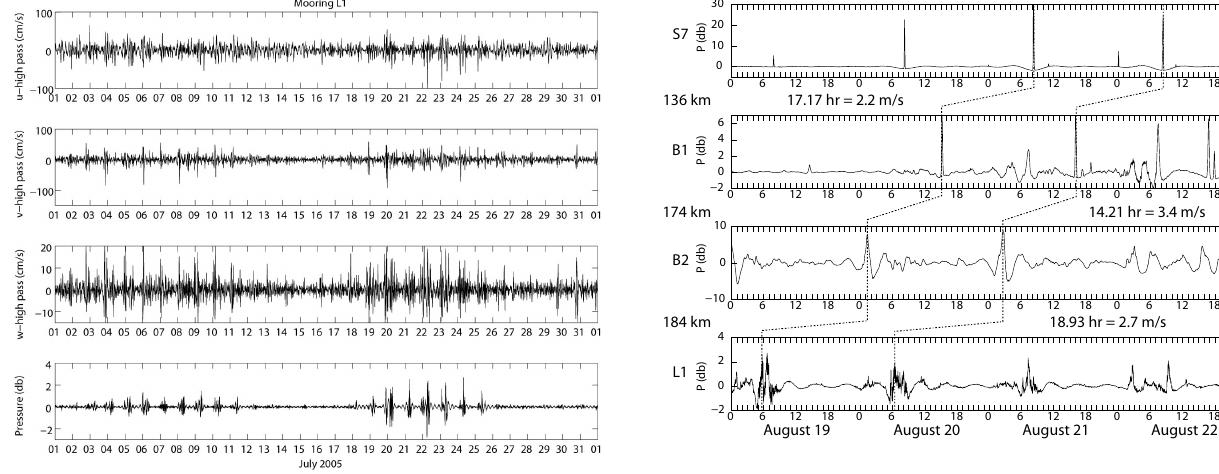
Fig. 12. High-pass filtered data from mooring L1. The top three panels are the u-, v-, and w-components from bin 8, approximately 422m depth (39m off the bottom). The bottom pressure series is from the instrument mounted just below the top sphere at 410m depth.